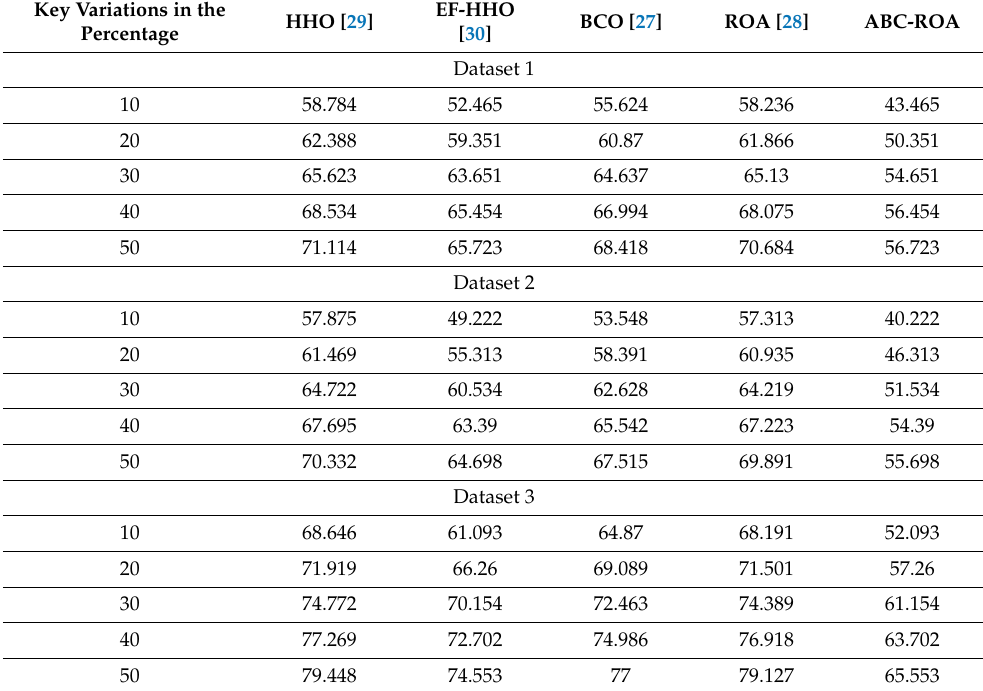
Table 3. Effectiveness analysis using CPA with three datasets for the developed blockchain-based data privacy preservation system over Ethereum